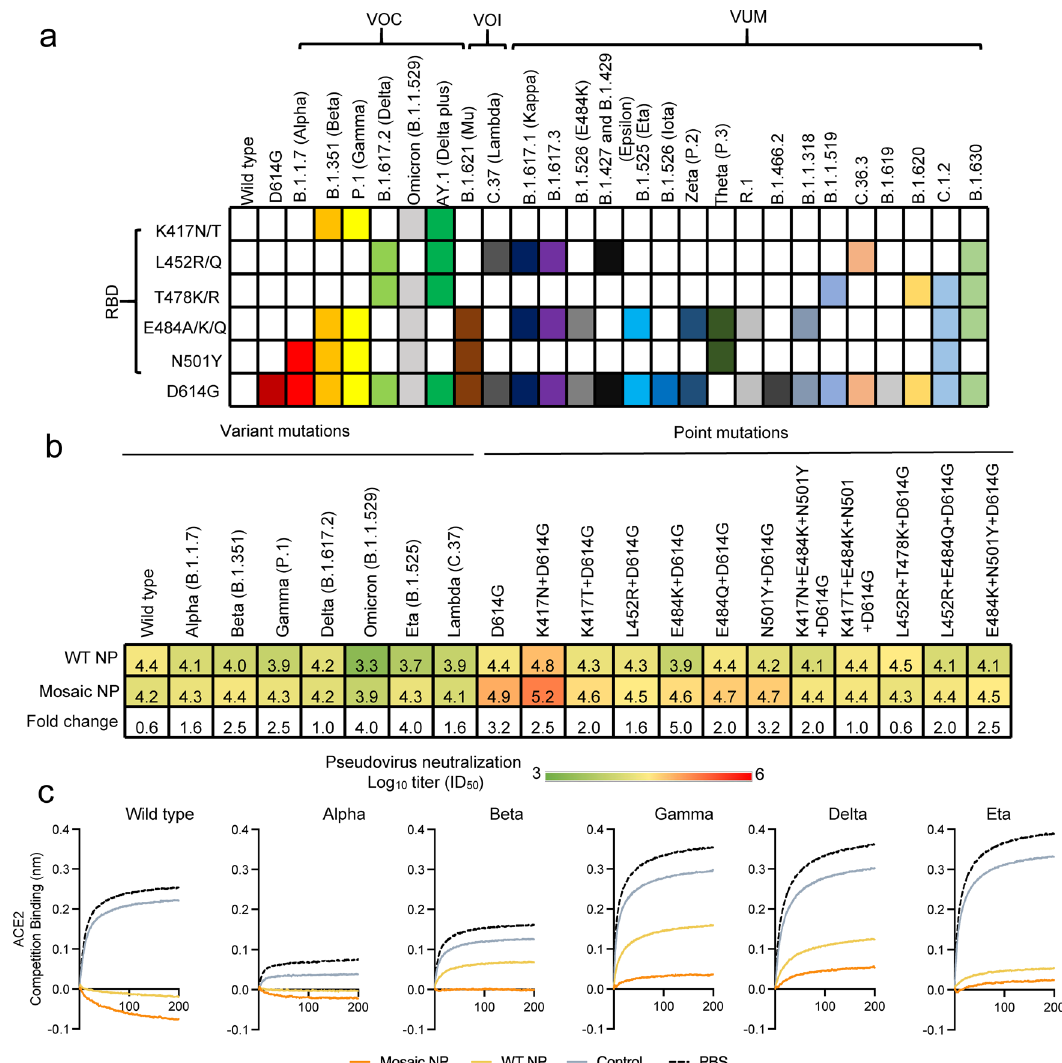
Fig. 4 Quadrivalent mosaic SARS-CoV-2 nanoparticle vaccine-elicited potent and broad neutralization antibody responses in cynomolgus macaques against pseudoviruses with various mutations in the RBD of SARS-CoV-2. a RBD key residue substitutions that affect the neutralizing sensitivity of ancestral and variant SARS-CoV-2 isolates are colored. The RBD residue mutations of circulating SARS-CoV-2 variants were downloaded from the Global initiative on sharing all in fl uenza data (GISAID) EpiCoV database. RBD receptor-binding domain, VOC Variant of Concern, VOI Variant of Interest, VUM Variants Under Monitoring. b Neutralization antibody titers of HexaPro-based SARS-CoV-2 nanoparticle vaccine-elicited sera 2 weeks after the second booster dose ( n = 4 cynomolgus macaques in each group) against a panel of SARS-CoV-2 mutant pseudoviruses. The neutralization titers were expressed as log 10 (means ± SD). The pseudoviruses neutralization titers were present as a heatmap colored in red-to-green gradient. A deeper red represents a higher pseudovirus neutralization activity, and a deeper green a lower pseudovirus neutralization activity. c BLI binding competition analysis with the hACE2 receptor of serum samples at peak potency collected from cynomolgus macaques that were vaccinated with HexaPro-based nanoparticle vaccines. Source data are provided as a Source Data fi